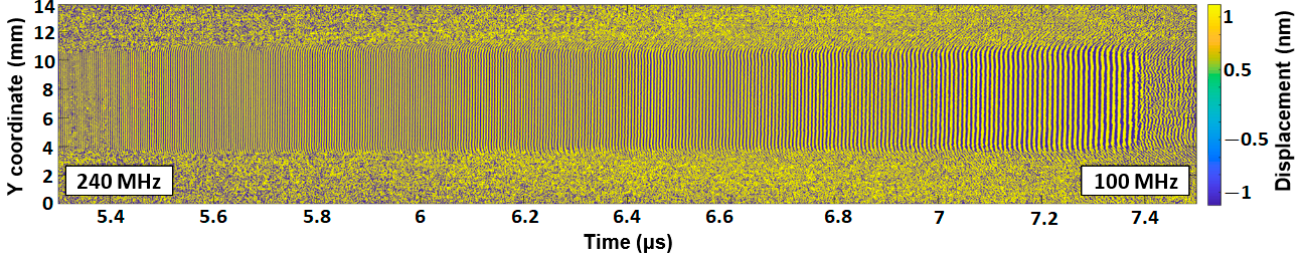
Figure 5. Optical measurement of the SAW emission by the chirped IDT: transversal B-scan showing the generated SAW packet.